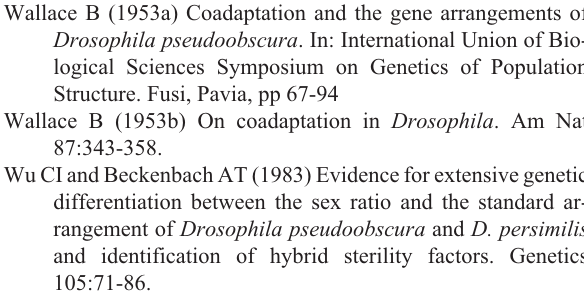
- Figure S1 - Reference photomap of Drosophila willistoni